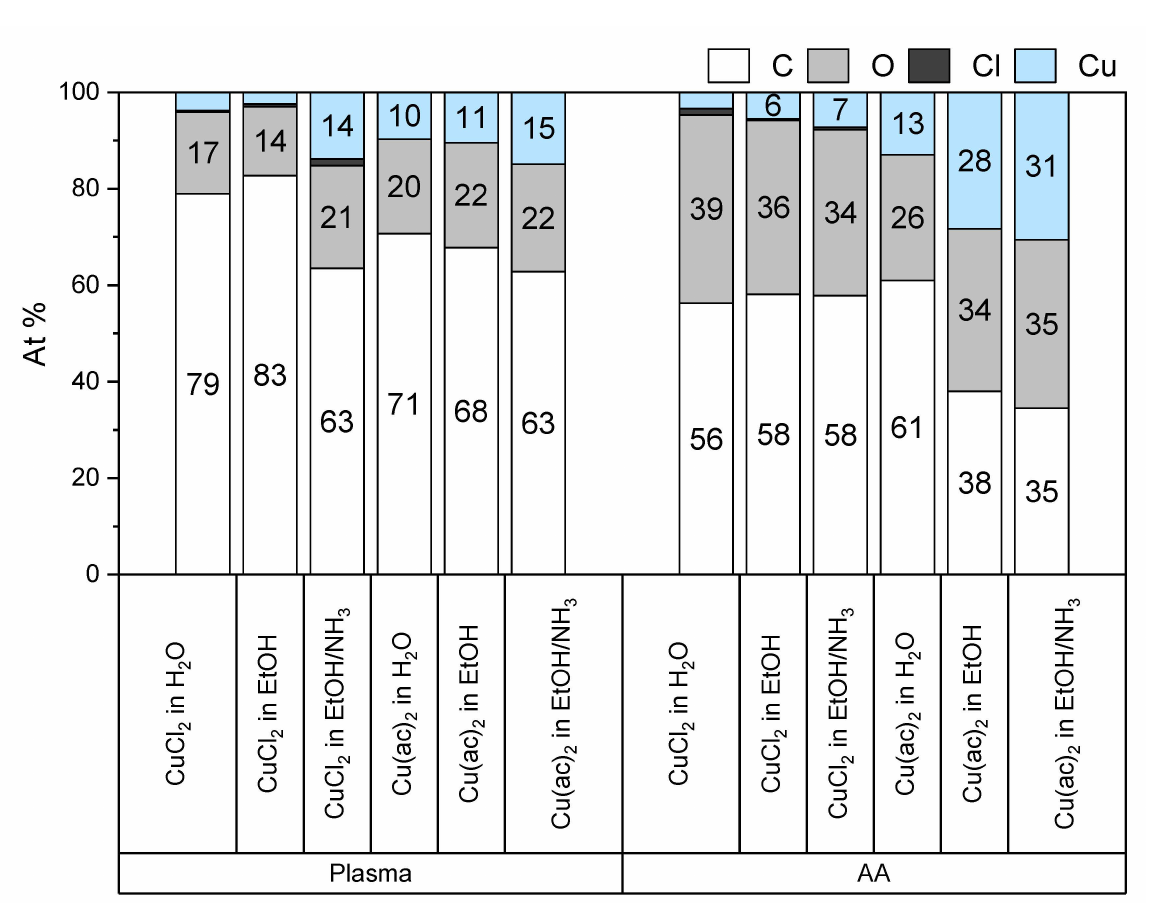
Figure 3. XPS data of the atomic composition (in At%) of surface-modified polystyrene samples after exposure to dissolved copper(II) salts. Plasma = plasma-treated, AA = acrylic-acid-grafted